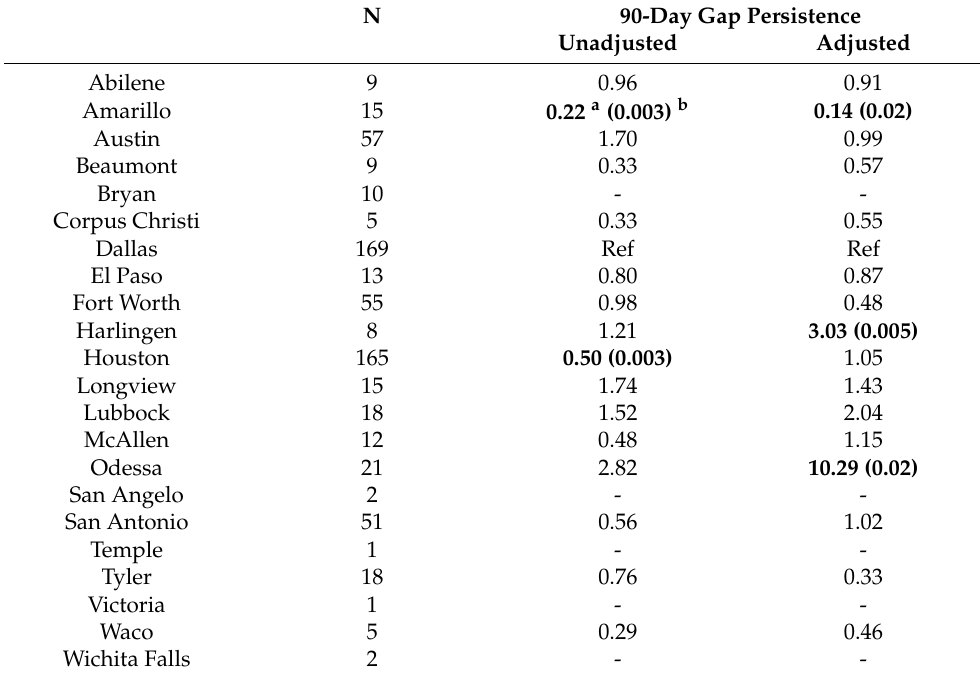
Table 4. Unadjusted and adjusted odds of AHT persistence by